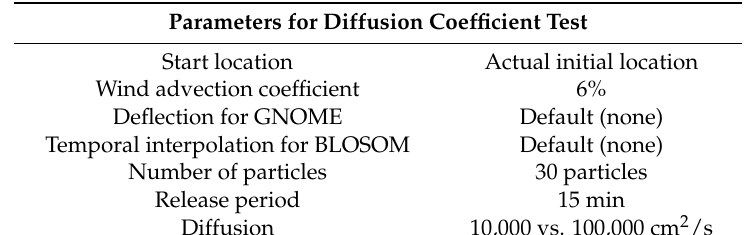
Table 12. Parameters for diffusion coefficient test.